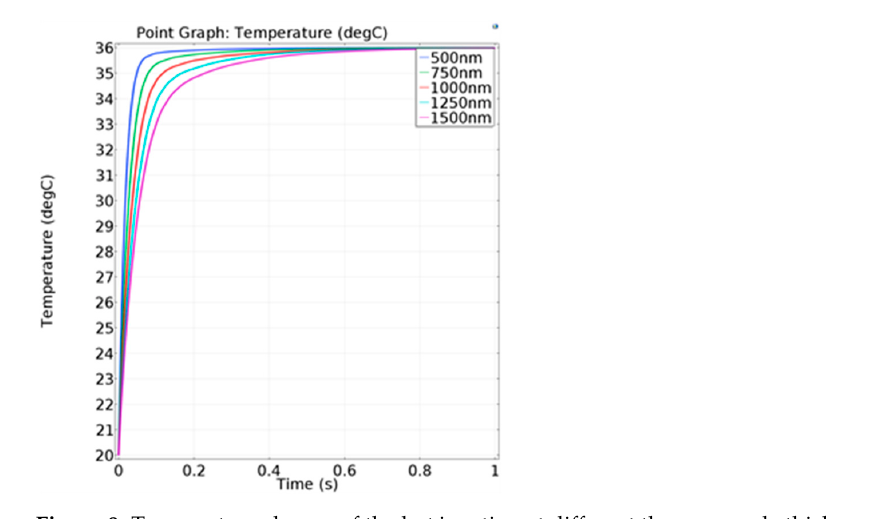
Figure 8. Temperature change of the hot junction at different thermocouple thicknesses. Table 1. Response of the thermocouple with different thickness. Table 1. Response of the thermocouple with different thickness.